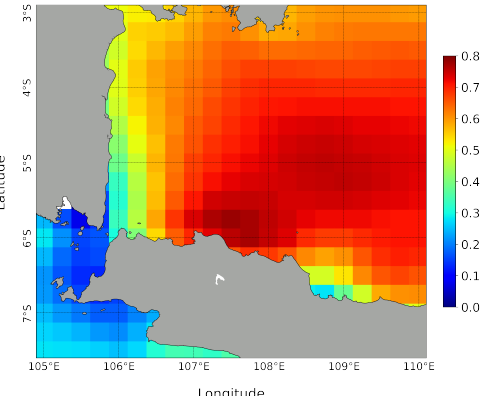
Figure 11. Similar as in Figure 10, for the northwestern area of the Java Sea.